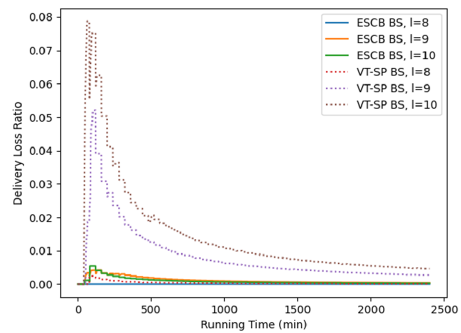
Figure 12. Delivery loss ratio for bearer services.